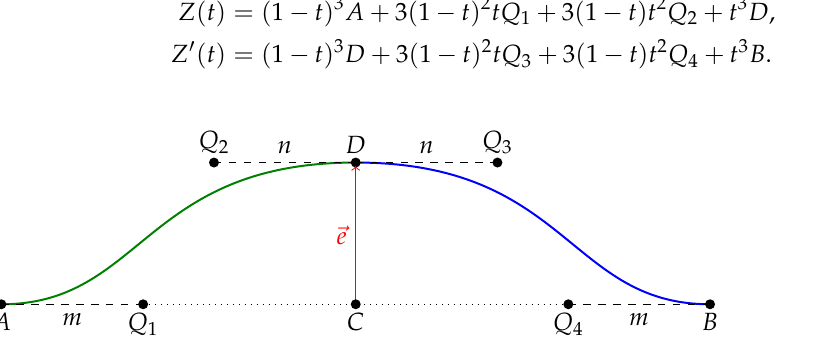
Figure 3. Geometry of the chosen shape for an arm link consisting of two cubic Bézier curves; A and B represent locations of the two